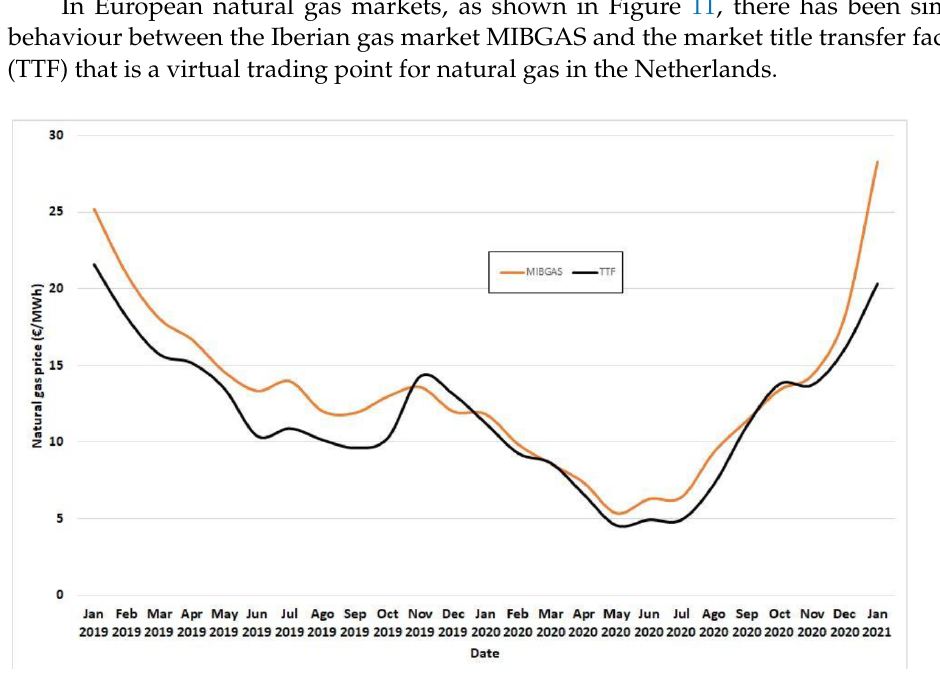
Figure 11. European natural gas prices in COVID-19 time. Source: own work based on MIBGAS data [6] and Elexys data